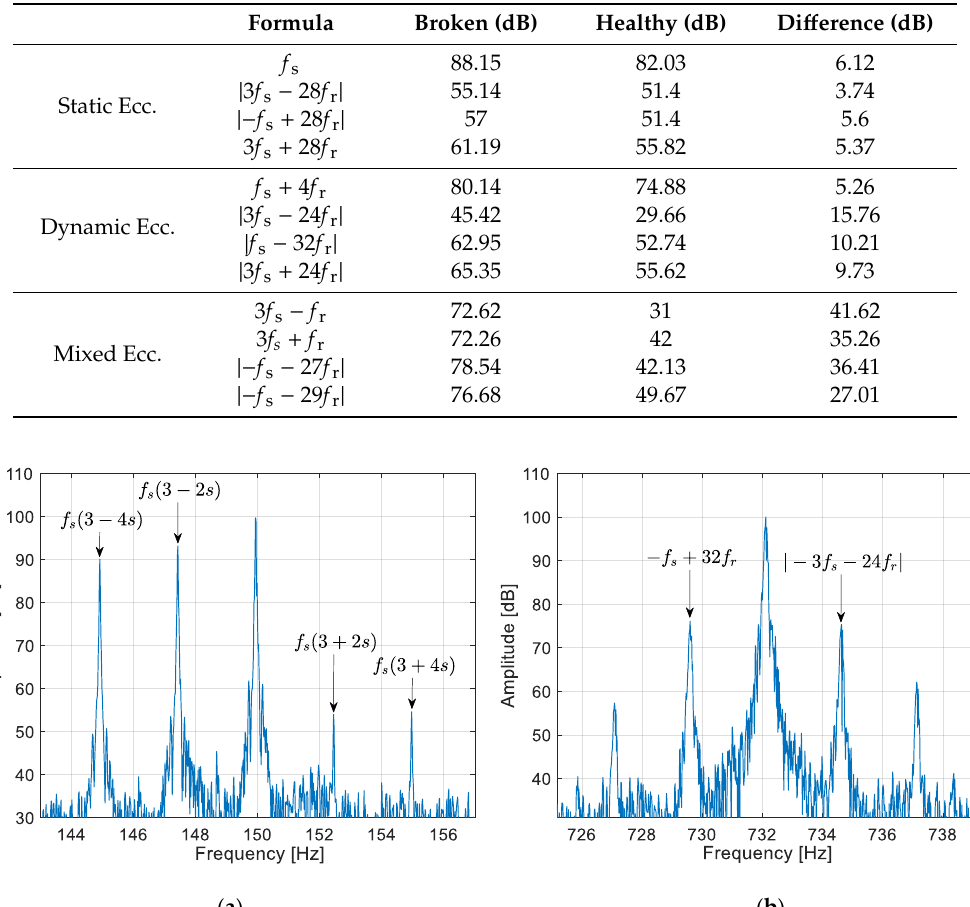
Table 10. Results of harmonics amplitude measurements of characteristic frequencies for a given type of eccentricity, obtained from laboratory tests.